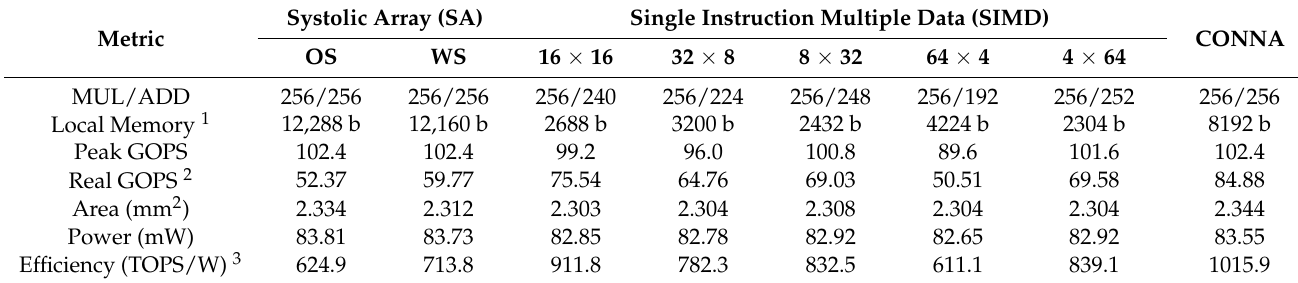
Table 6. Summary of implementation evaluation on three types of neural network accelerators.